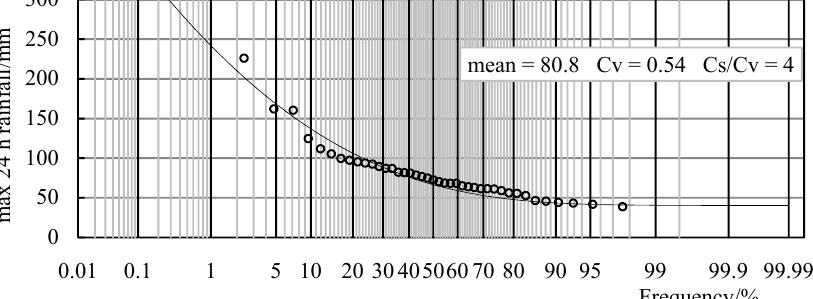
Figure 7. The frequency curve of the maximum 24 h rainfall of discontinuous 40 years in 1978~2020 at Wulongmiao station.